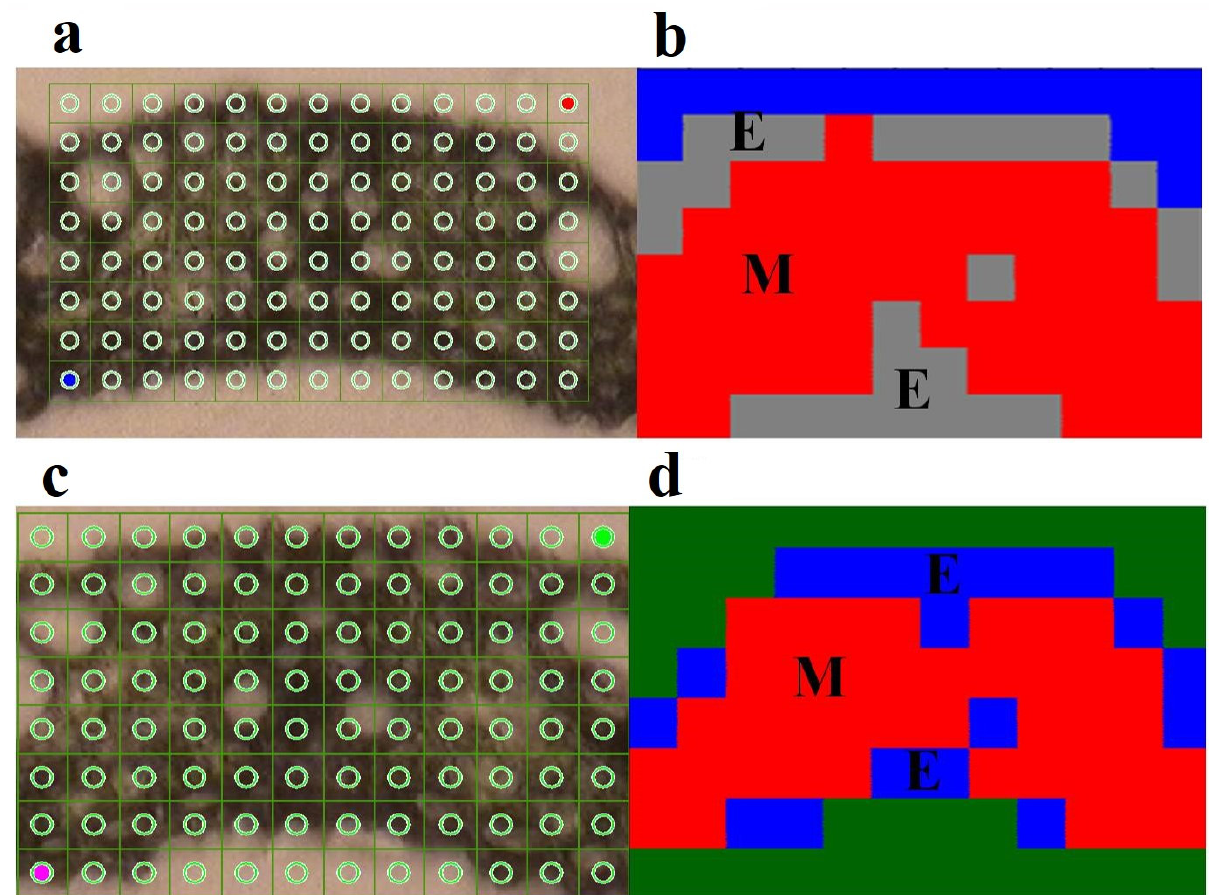
Figure 4. Representative sample of functional group area maps obtained in the spectral region between 1750 and 900 cm − 1 . KDML 105 rice leaves were treated and not treated with the natural plant elicitor BIG ® against BLB disease caused by Xoo. ( a ) The measurement was performed by means of point-to-point mapping using SR-FTIR microspectroscopy over an area of 130 × 80 µ M of rice leaves of cv. KDML 105, were used as a control. ( b ) HCA mapping of rice leaves of cv. KDML 105, used as a control. ( c ) The measurement was performed by means of point-to-point mapping using SR-FTIR microspectroscopy over an area of 120 × 80 µ M of rice leaves of cv. KDML 105 treated with the natural plant elicitor BIG ® . ( d ) HCA mapping of rice leaves of cv. KDML 105 treated with the natural plant elicitor BIG ® (E, epidermis; M, mesophyll).